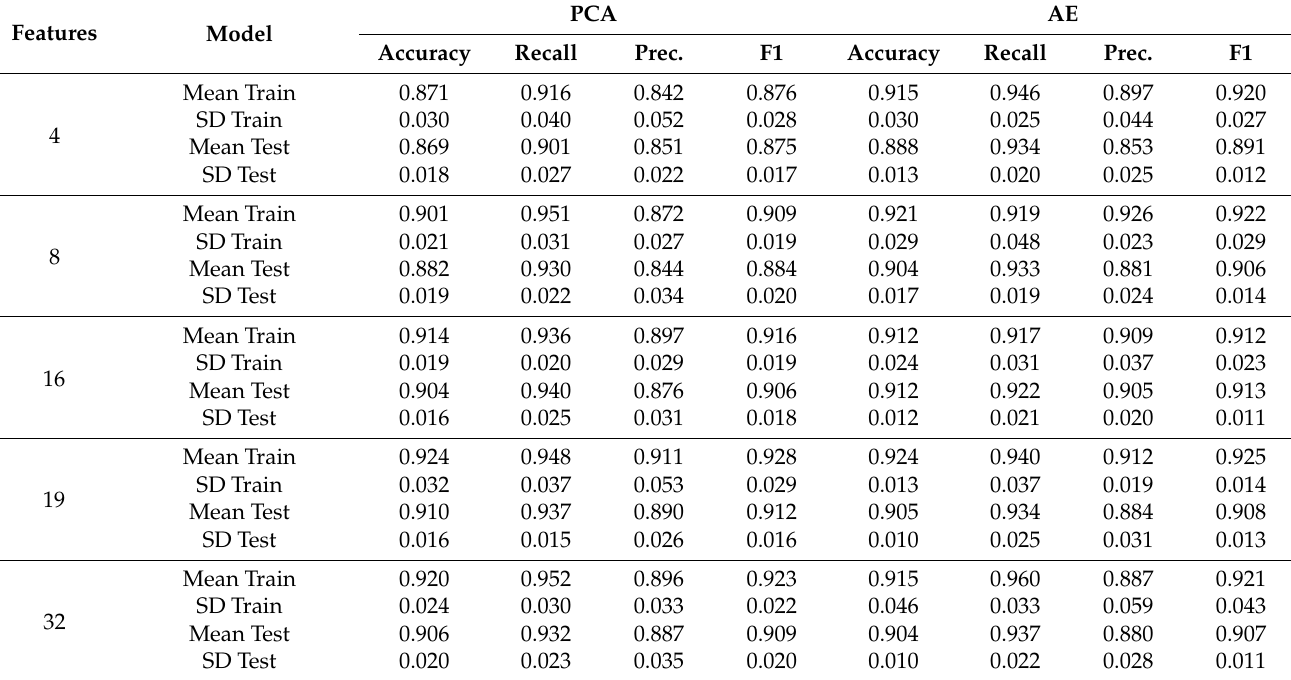
Table A2. Binary classification metrics for k-NN per number of PCs and AE latent space dimensionality.